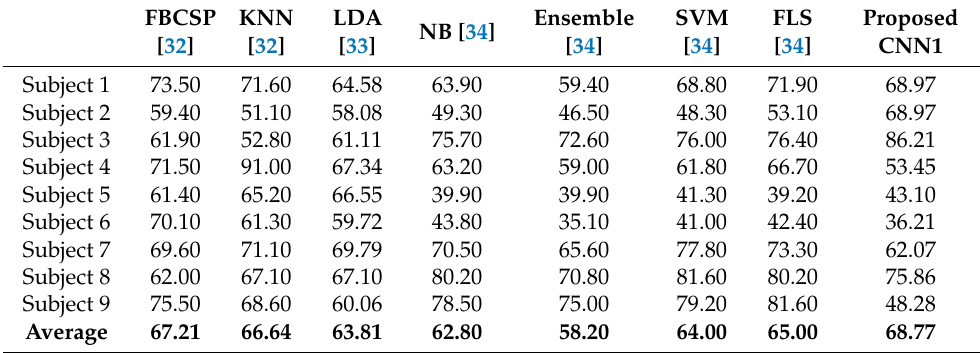
Table 7. Comparison of the classification accuracy